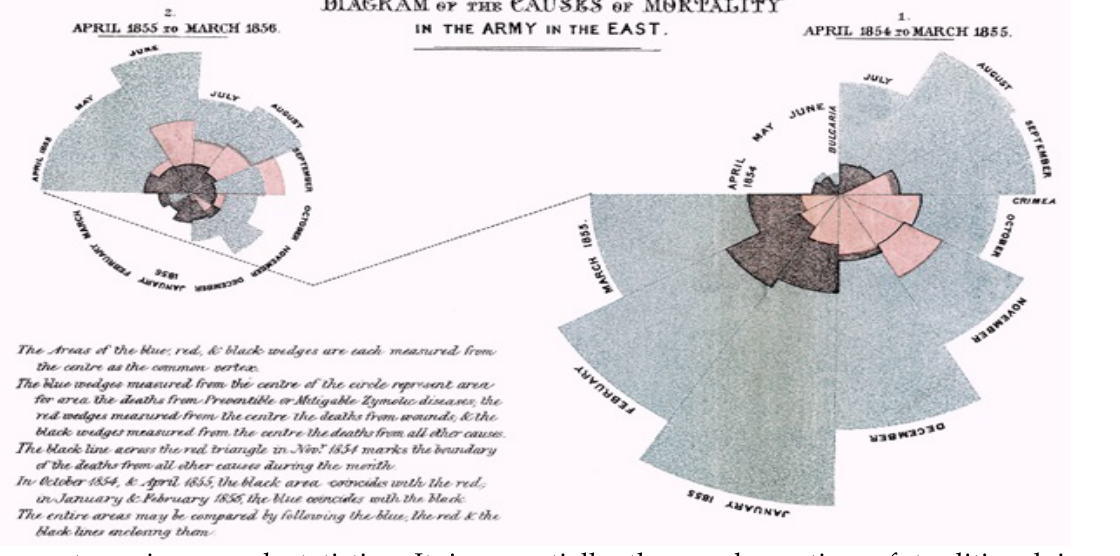
Figure 2: ‘Mortality of the British Army’ by Florence Nightingale’s Report Interactive Version (Rogers, 2010)